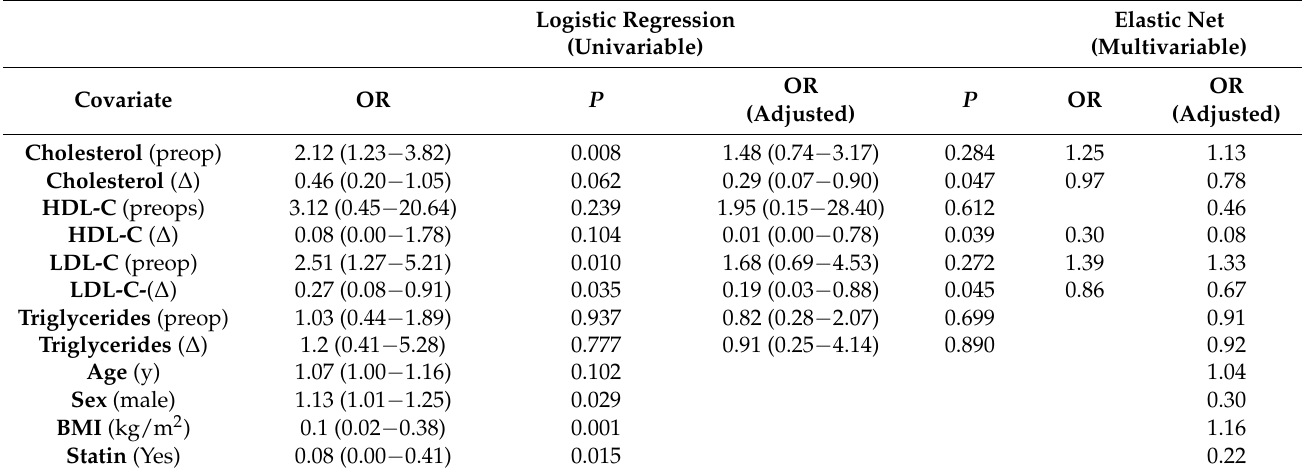
Table 4. Association between individual lipids (in units (mmol/L)) and the outcome postoperative stroke. Preoperative values as well as their change during the operation (postoperative minus preoperative) are presented. The left part of the table shows odds ratios (OR) and their 95% confidence intervals for univariable regressions, both for the crude association and adjusted for the confounders age, sex, BMI, and statins. The right part shows the OR computed by an elastic net logistic regression to account for the correlation across the lipids. An OR > 1 refers to increased risk, and an OR < 1 refers to a protective effect with respect to a unit change in a particular characteristic.